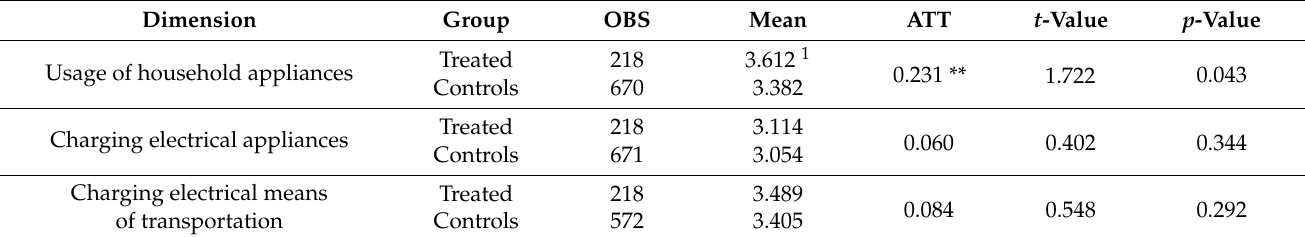
Table 1. Demand flexibility comparisons of solar owners (treated) versus non-owners (controls) (source: authors’